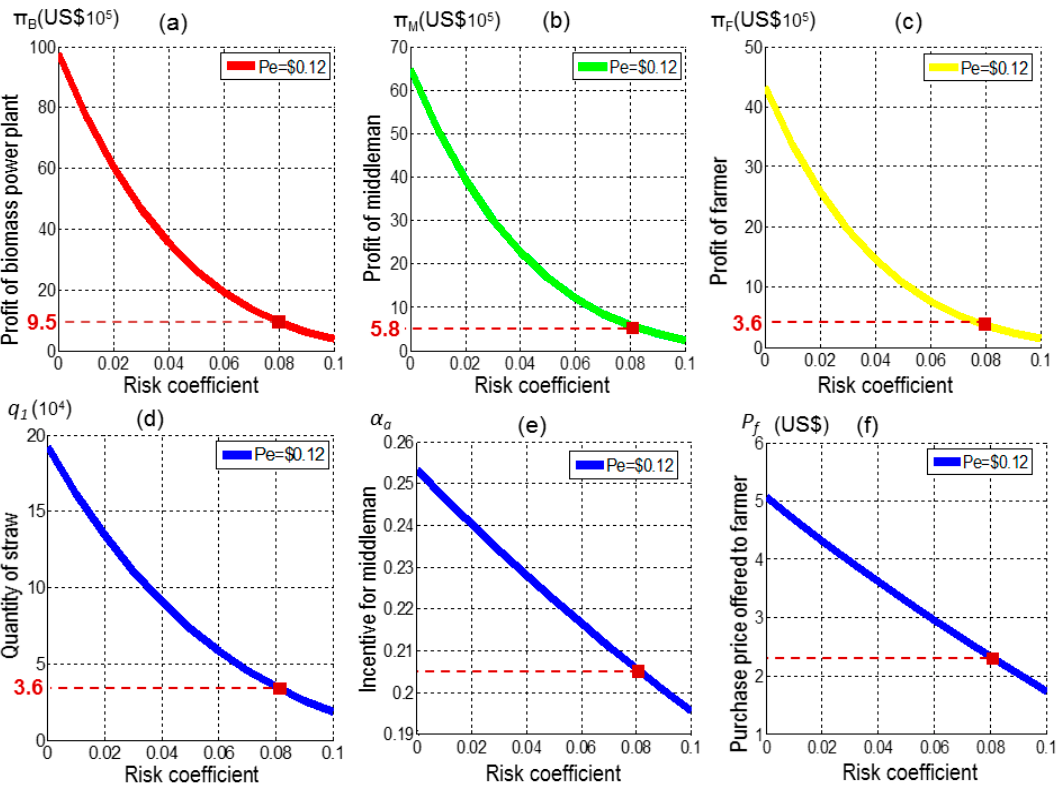
Figure 4. Changes of profits and α a , p f , and q 1 under risk perception in the current incentive situation. ( a ) Description of profit change of biomass power plant; ( b ) Description of profit change of middleman; ( c ) Description of profit change of farmer; ( d ) Description of α a change ( e ) Description of p f change; ( f ) Description of q 1 change.